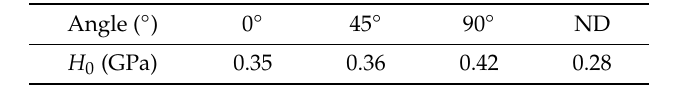
Table 3. Strength of the magnesium AZ31 alloys. Angle (°)